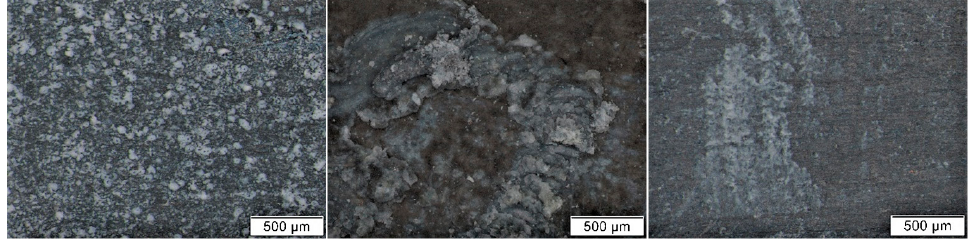
Figure 10. Details of lead coupons from a wooden showcase, a case with an acetate film, and a wooden box with an acetate film (locations 11, 12, and 18) after 30-month exposure.